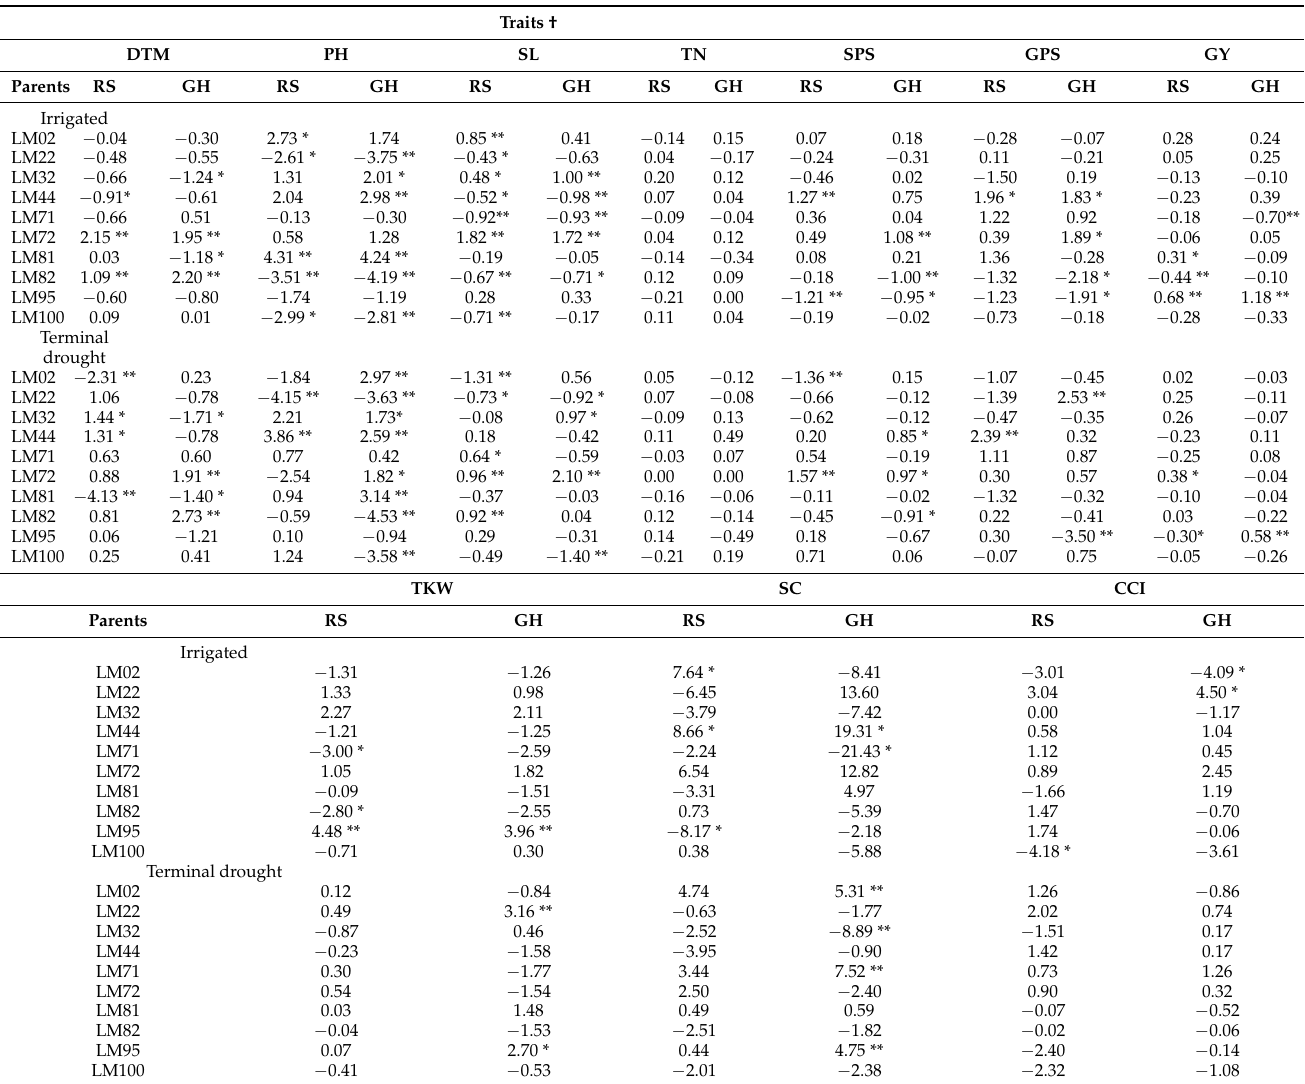
Table 3. General combining ability effects for studied agronomic and physiological traits among 10 parental bread wheat genotypes of bread wheat evaluated under irrigated and terminal drought conditions in rainout shelter (RS) and glasshouse (GH)